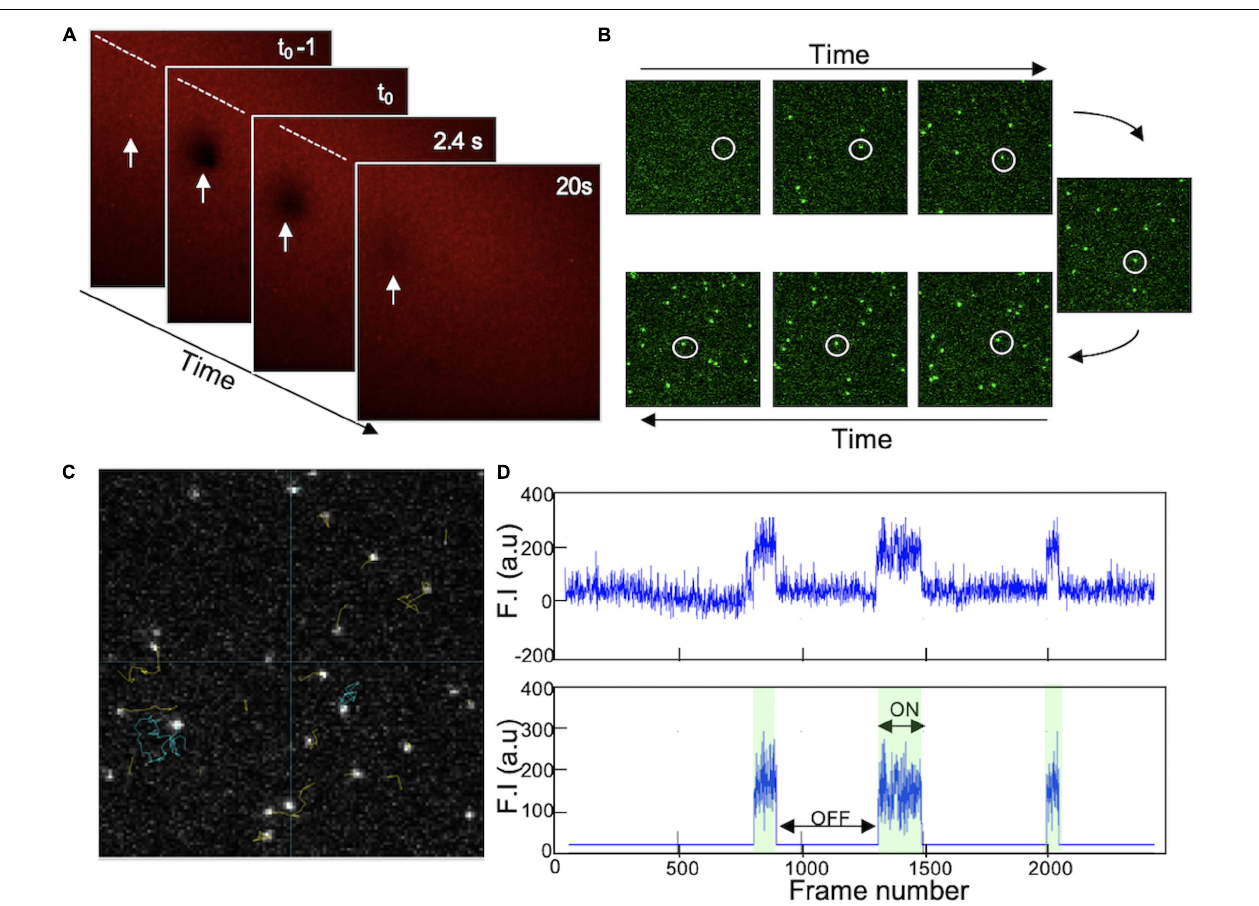
FIGURE 5 | (A) Supported lipid bilayer on glass formed by vesicle fusion of SUVs (78.9% DOPC, 20% DOPS, and 1% PI4P) in the presence of CaCl 2 . Homogeneous fluorescent signal is detected due to 0.1% DiIC18(3) added to the lipid mix. Fluorescence photobleaching (white arrow) was performed using a confocal microscope and the recovery of the intensity validate the lateral lipid diffusion and the quality of the SLB. Photobleaching occurs at t 0 . (B) TIRF images acquired at different timepoint when injecting DrrA on SLB. Fluorescently labeled protein (DrrA sortase labeled with Alexa Fluor 647) was added at 100 pM on the top of SLB containing 1% PI4P. The interaction of DrrA with membrane was observed using TIRF microscopy allowing higher resolution for single molecule tracking. The white circles showed the arrival of DrrA molecule after injection and its diffusion on the surface of SLB. Images are 128 × 128 pixels. (C) Processed image shows trajectory of individual protein diffusing on the membrane analyzed using MatLab. (D) Fluorescence traces over time of individual protein (raw signal on top, and background processed signal at the bottom) showing the protein residency time (Binding or ON events) and the unbinding (OFF events). All reproduced by J. S. from Schoebel et al. (2010); Del Campo et al. (2014), and Sidm and Wang